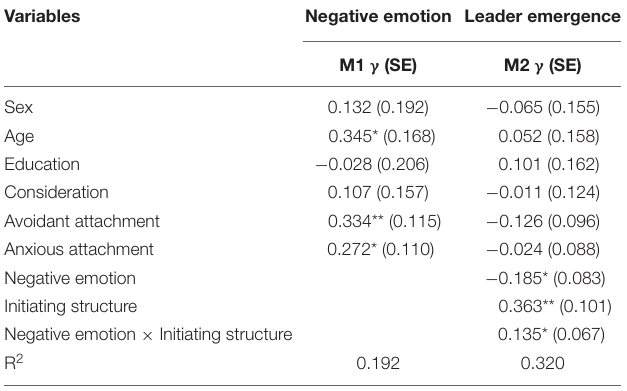
positively related to negative emotion ( γ = 0.334, SE = 0.115, p = 0.004; γ = 0.272, SE = 0.110, p = 0.013). Therefore, hypothesis 1 was